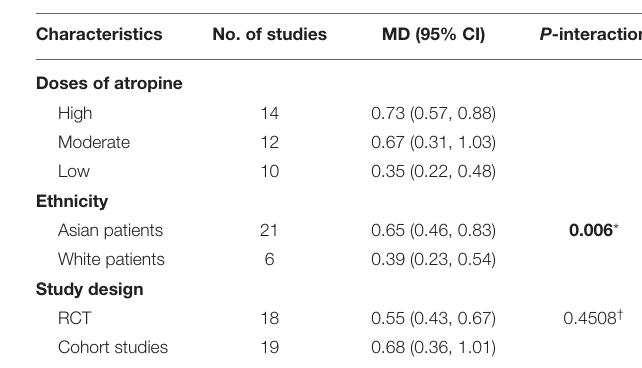
TABLE 2 | Test for interaction on mean annual refraction change by doses of atropine, ethnicity, and study